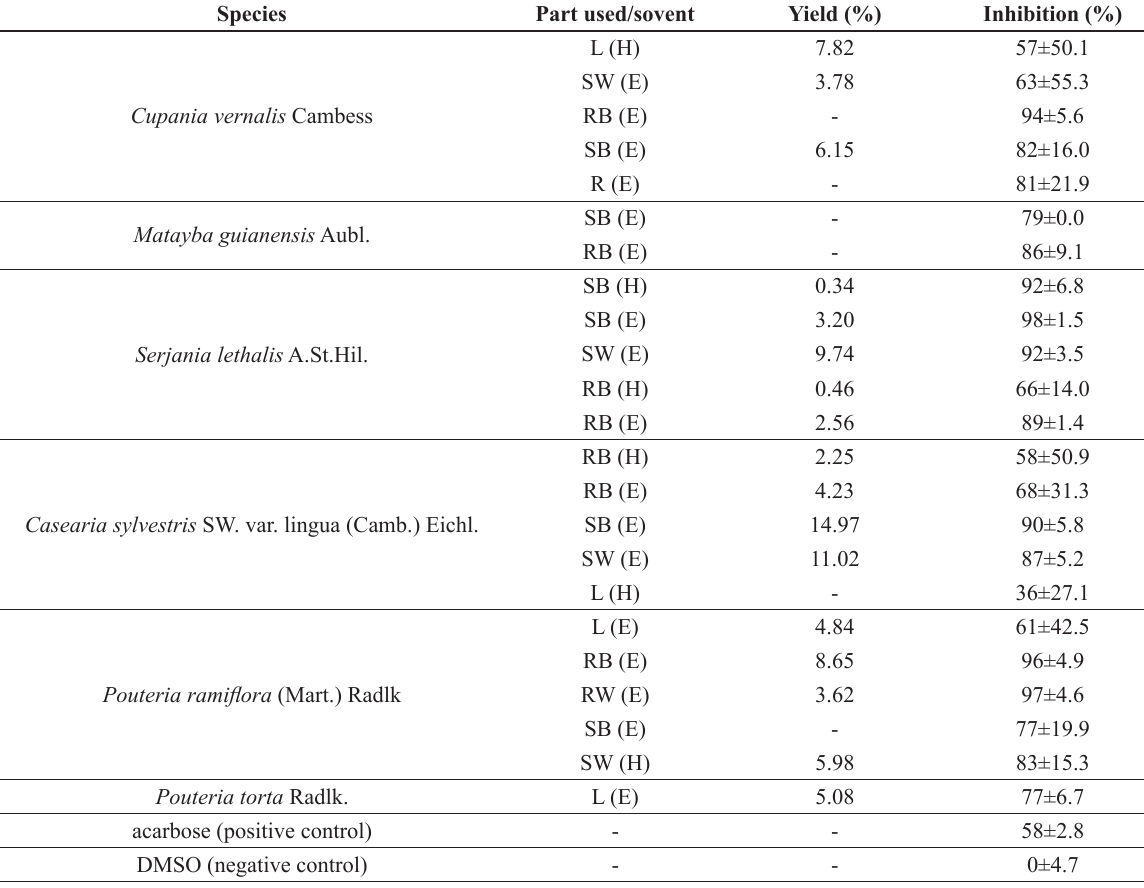
Plant species investigated, part used/solvent, yields in terms of dry starting material and percentage of inhibitory activity of crude extracts on human salivary